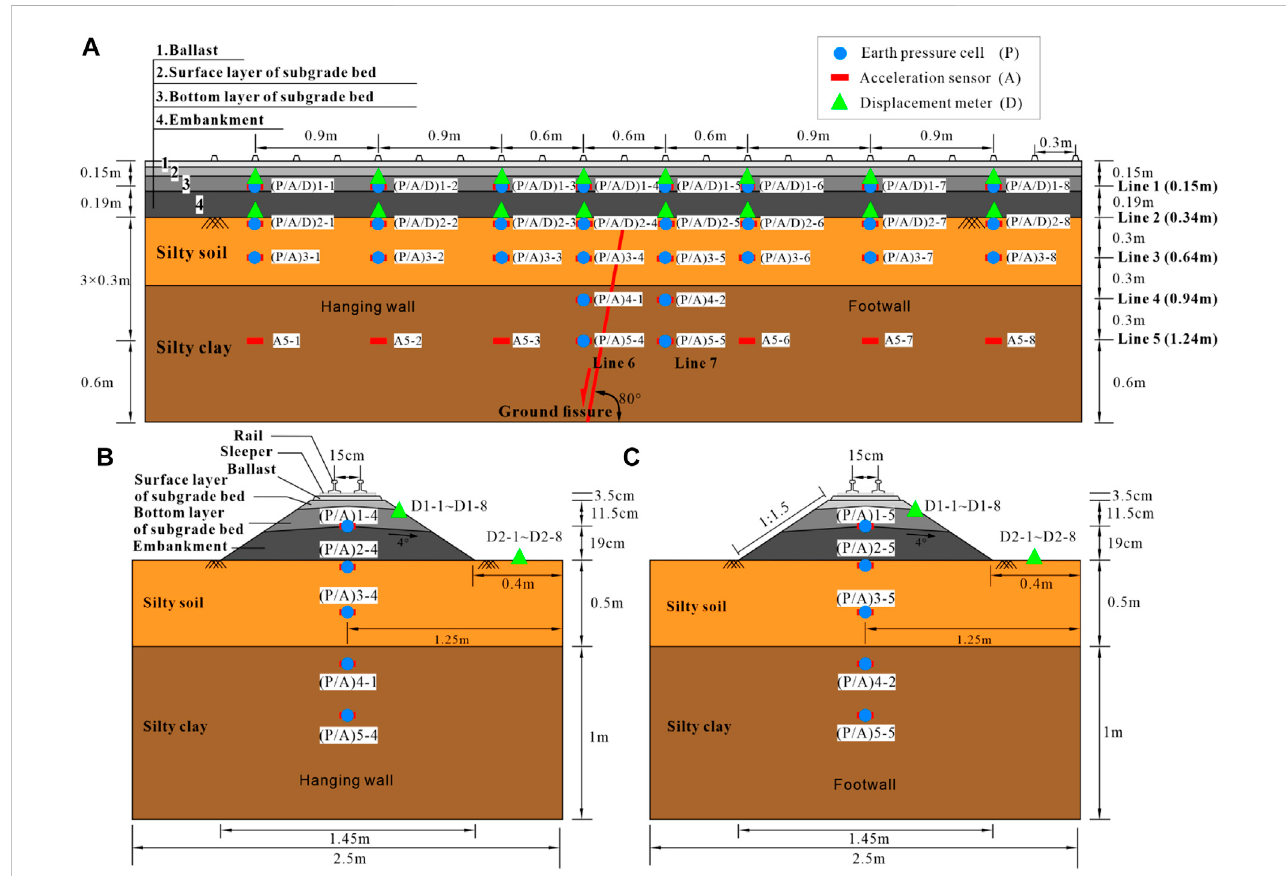
FIGURE 7 Schematic diagram of measuring points section in Model test. (A) Longitudinal section view; (B) Horizontal section in the hanging wall (Line 6); (C) Horizontal section in the footwall (Line 7).